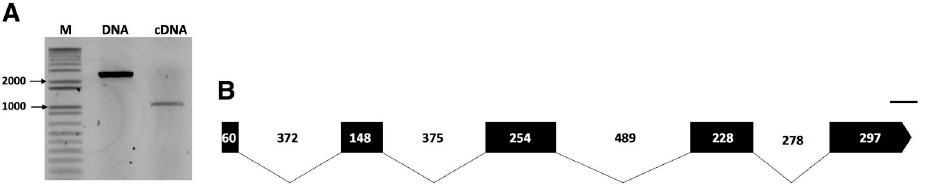
Fig 1. Molecular characterization of the pectin methylesterase ( Pp-pme ) of Pratylenchus penetrans . (A) Amplicons of both genomic (2,501 bp) and cDNA coding (987 bp) sequences of Pp-pme , respectively. (B) Schematic representation of the Pp-pme gene structure. Relative positions and respective sizes of the exons are indicated by dark boxes and introns by lines.